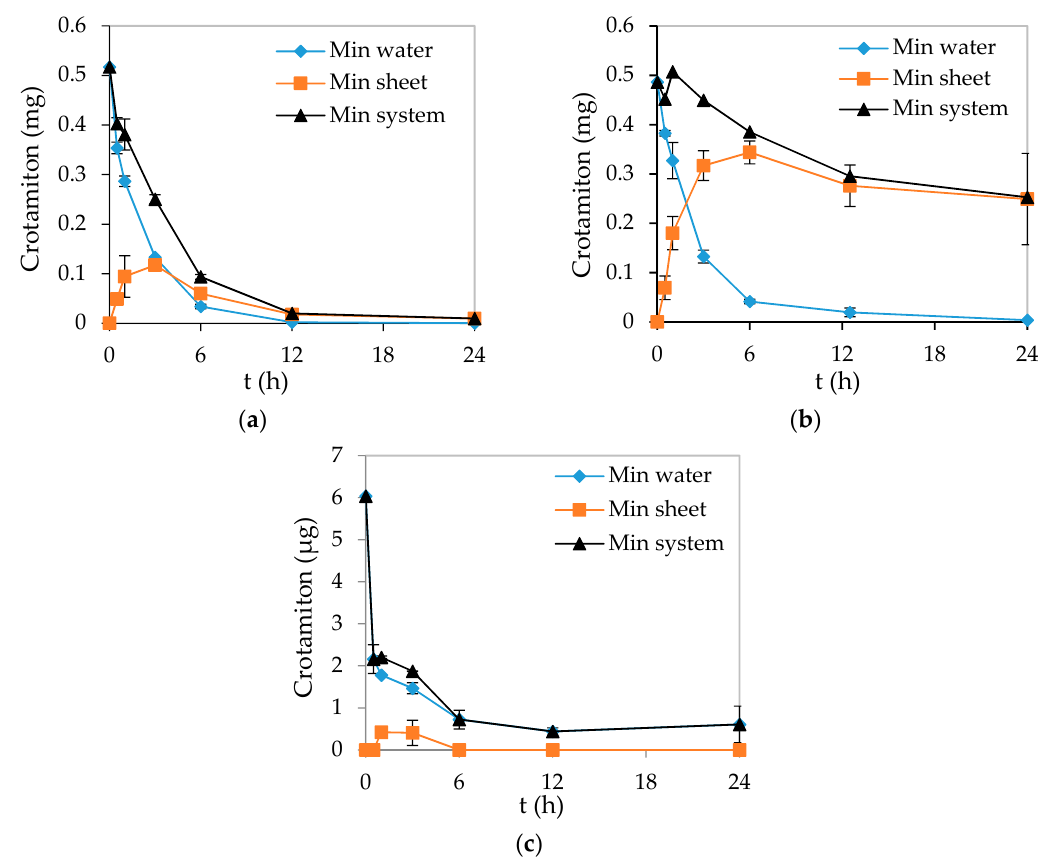
Figure 5. Removal of crotamiton using the HSZ-385/P25 composite sheet with ultraviolet irradiation for solutions of ( a ) 10 mg/L crotamiton in ultrapure water; ( b ) 10 mg/L crotamiton in RO concentrate; and ( c ) 120 μ g/L crotamiton in RO concentrate. Results are means ± standard deviations ( n = 2).